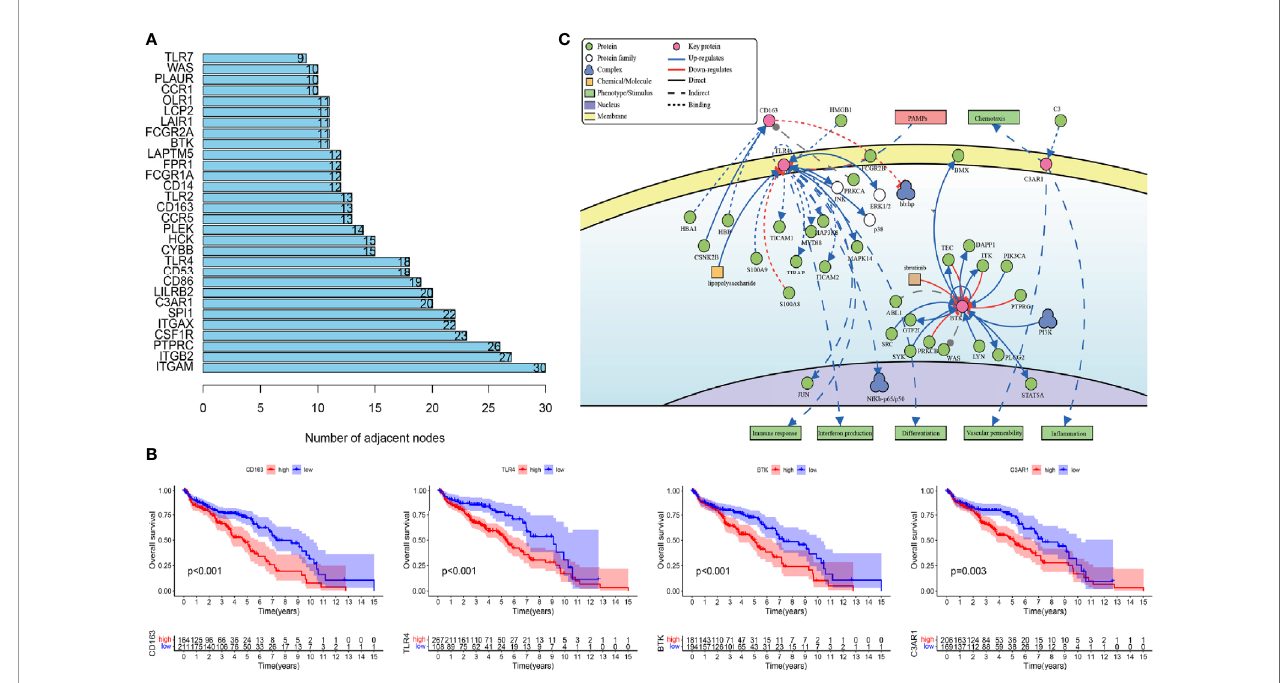
FIGURE 6 | (A) Gene nodes ranked among the top 30 in the PPI analyses. PPI, protein-protein interaction. (B) Kaplan-Meier curves of overall survival in four prognostic key IRGs. IRGs, immune related genes. (C) The causal interaction of key gene analysis in